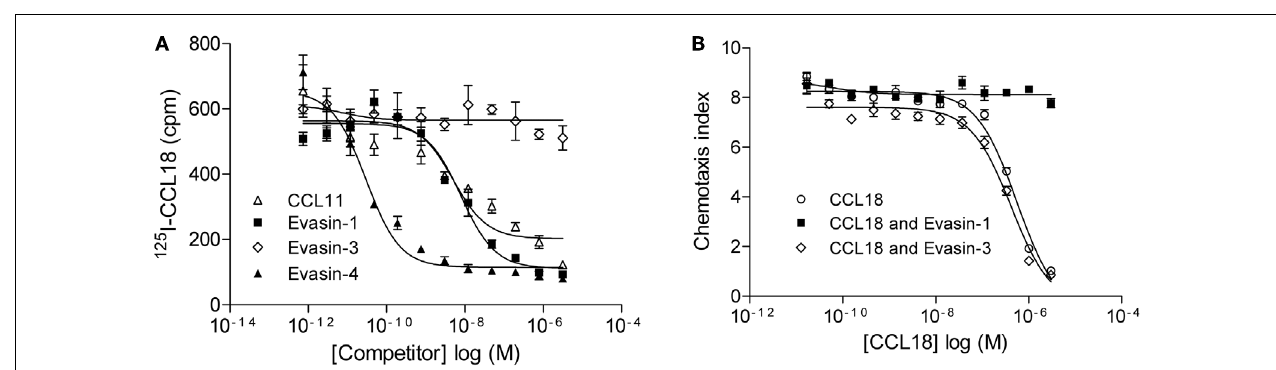
Migration of L1.2/CCR3 transfectants to a constant concentration of 1nM CCL11 was inhibited by an increasing concentration of CCL18 (IC 50 : 556.8nM).The effect of Evasin-1 on the antagonistic activity of CCL18 on CCR3 was assessed by the incubation of CCL18 with a twofold access of Evasin-1. Evasin-3 (IC 50 : 421nM) was used as a control. Data are expressed as chemotaxis index ± SEM. Data points are in triplicate. One representative experiment out of two is shown.